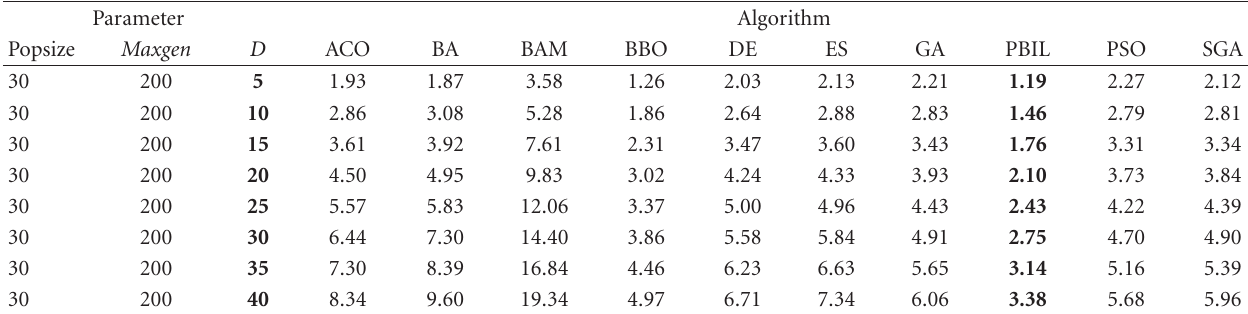
Table 9: Average CPU time on UCAV path planning problem on di ff erent D . The numbers shown are the minimum average CPU time (sec) consumed by each